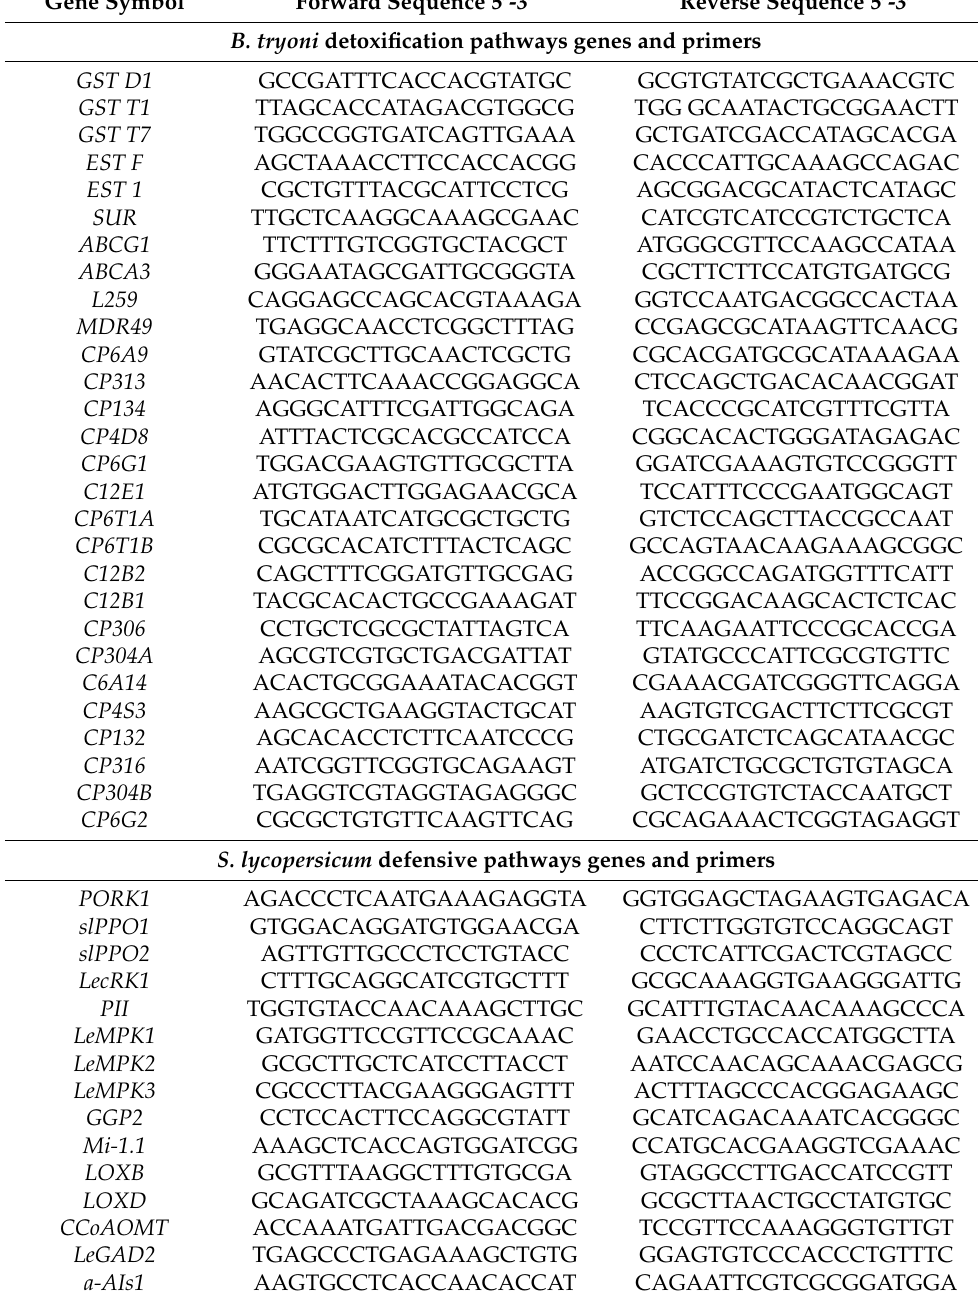
Table 2. Primer pairs for genes selected for studying the plant-induced defence/insect detoxification interactions occurring between Bactrocera tryoni larvae feeding in Solanum lycopersicum fruit. The primer development and primer check processes for these genes are provided in Roohigohar et al. (2021). Gene Symbol Forward Sequence 5 (cid:48) -3